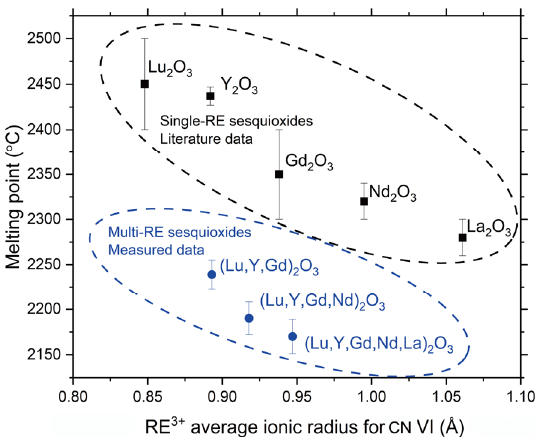
Fig. 7 Measured melting points of the compositions from the system of composition 3 (Lu,Y,Gd,Nd,La) 2 O 3 (blue circles) are lower than those of Lu 2 O 3 [33], Y 2 O 3 [36], Gd 2 O 3 [35], Nd 2 O 3 [33], and La 2 O 3 [36] (black